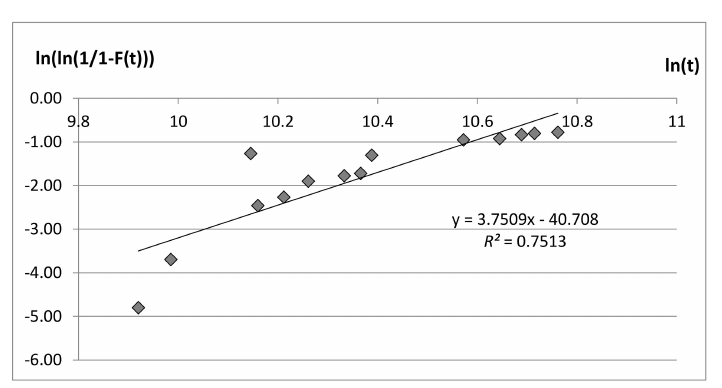
Figure 2. Weibull chart of board_WS—Prj1